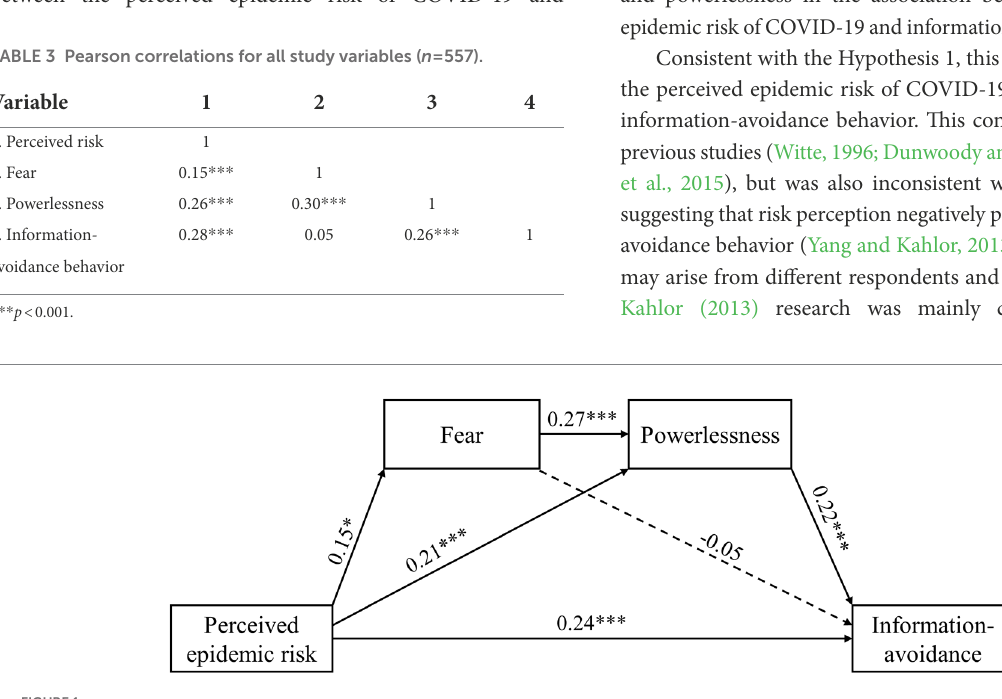
FIGURE 1 Structural equation model of the direct effect of perceived epidemic risk on other variables and the mediating effects of fear and powerlessness. The dotted lines indicate non-significant relationships. * p < 0.05, *** p <